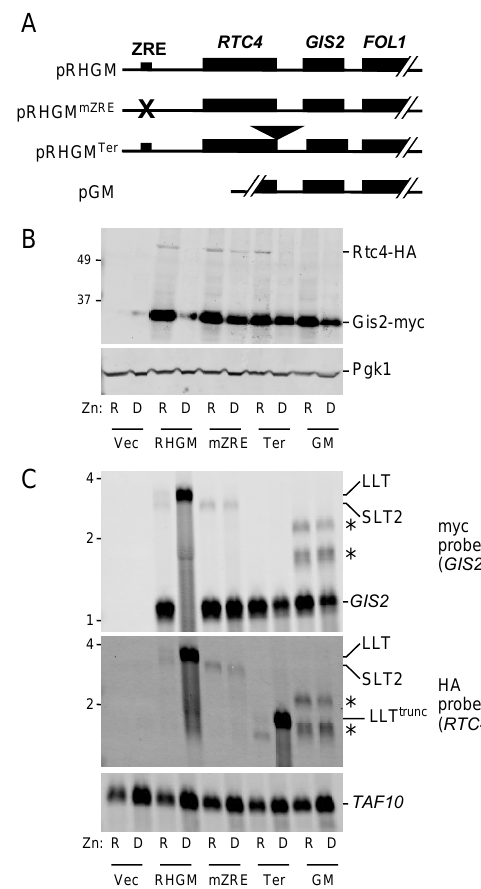
Figure 5. Mutagenesis analysis of RTC4 and GIS2 co-regulation. Wild-type (BY4741) cells were transformed with plasmids pRHGM, pRHGM mZRE , pRHGM Ter , or pGM were grown in grown in zinc-replete (R, LZM + 100 µ M ZnCl 2 ) or deficient (D, LZM + 1 µ M ZnCl 2 ) media prior to analysis. ( A ) Diagram of the plasmids used in this experiment. ( B ) Immunoblot analysis of Rtc4-HA, Gis2-myc, and Pgk1. ( C ) Northern blot analysis of RNA expression using HA tag and myc tag-specific probes. TAF10 was used as a loading control. The locations of the GIS2 and RTC4 SLT2 mRNAs are marked as well as the LLT RNA and truncated LLT RNA produced in the pRHGM Ter transformant. RTC4 SLT1 was not detectable in this experiment because of its low abundance. The asterisks mark two transcripts that arise from transcription initiation in the plasmid vector for pGM. The location of size markers is indicated on the left side of each panel in kDa (panel B) or kb (panel C).